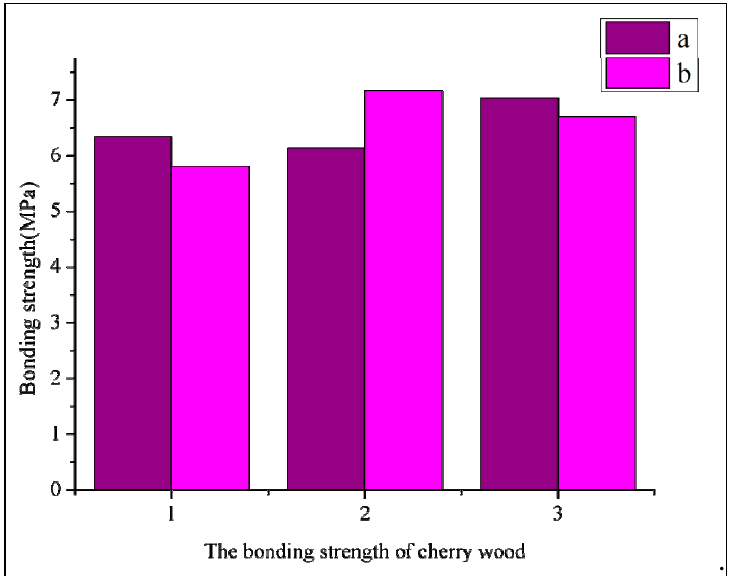
Figure 6. Bonding of thermo-treated cherry wood: ( a ) non-thermo-treated and ( b ) thermo-treated. 1: 1: non-treated, 2: nitrogen plasma treated, and 3: oxygen plasma non-treated, 2: nitrogen plasma treated, and 3: oxygen plasma treated.